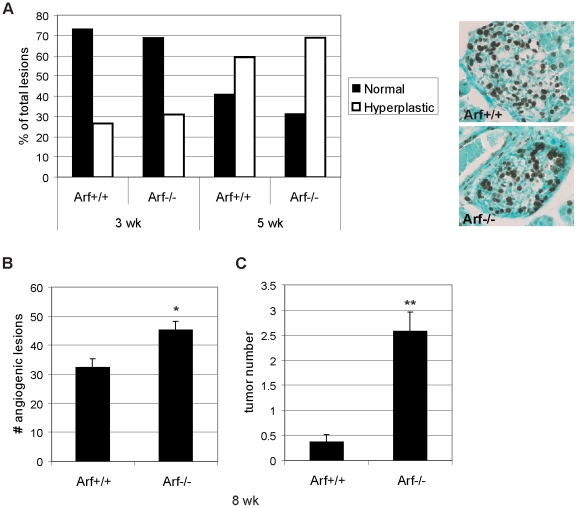
Effects of Arf knockout on the hyperplastic and angiogenic switches during RIP-Tag2 tumorigenesis.(A) Effects on the hyperplastic switch. Islets from Ki67-stained sections from 3- or 5-week old mice were scored as “normal” (no hyperproliferation) or hyperplastic. Values represent the distribution of the different islet subclasses within the indicated genotypes. For 3-week mice, 60 (Arf+/+) and 58 (Arf−/−) islet lesions were scored on sections from 3 mice/group; for 5-week old mice, 166 (Arf+/+) and 231 (Arf−/−) islet lesions were scored on sections from 3–4 mice/group. The distribution of islet types was not significantly different between the two genotypes at either time point (Fisher's exact test; 5 week timepoint: p = 0.06). Representative Ki67-stained hyperplastic lesions (from 3-week old RIP-Tag2 mice) of the indicated Arf genotypes are depicted on the right. (B, C) Effects on the angiogenic switch and tumor initiation. The number of red, angiogenic lesions (B) and tumors (C) was calculated from 11 (Arf+/+) or 15 (Arf−/−) 8-week old RIP-Tag2 mice of the indicated genotypes. Mean values ±SEM are indicated. Mann-Whitney test for statistical significance; *p = 0.01, **p<0.0001.